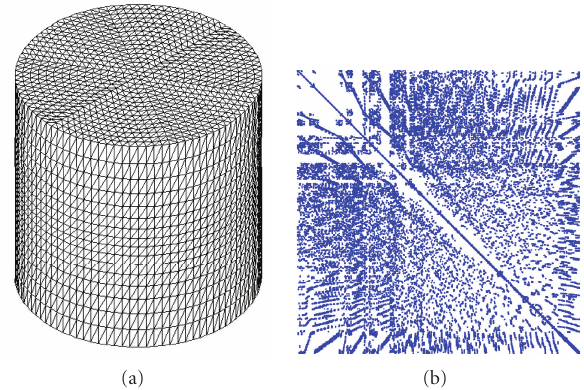
Figure 5: Cylinder geometry for the forward and inverse solver problems, showing a mesh with 83142 nodes and 444278 tetrahedral elements (b). The fill structure of the resulting FEM system matrix is shown on the right. The number of nonzeros is 1150264, resulting in a fill fraction of 1 . 664 · 10 − 4 .